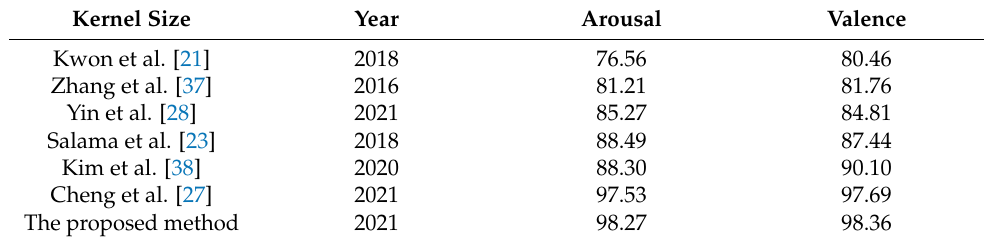
Table 4. Comparison among previous research on arousal and valence binary classification. Kernel Size